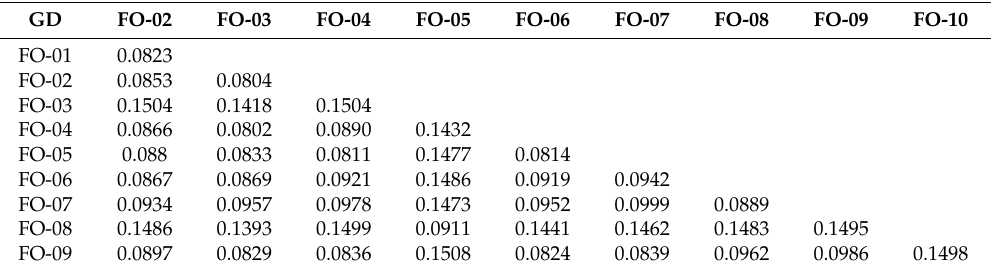
Table 3. Nei’s genetic distance matrix of 10 F. ovina populations based on AFLP (amplified fragment-length polymorphism) profiles. Genetic distance